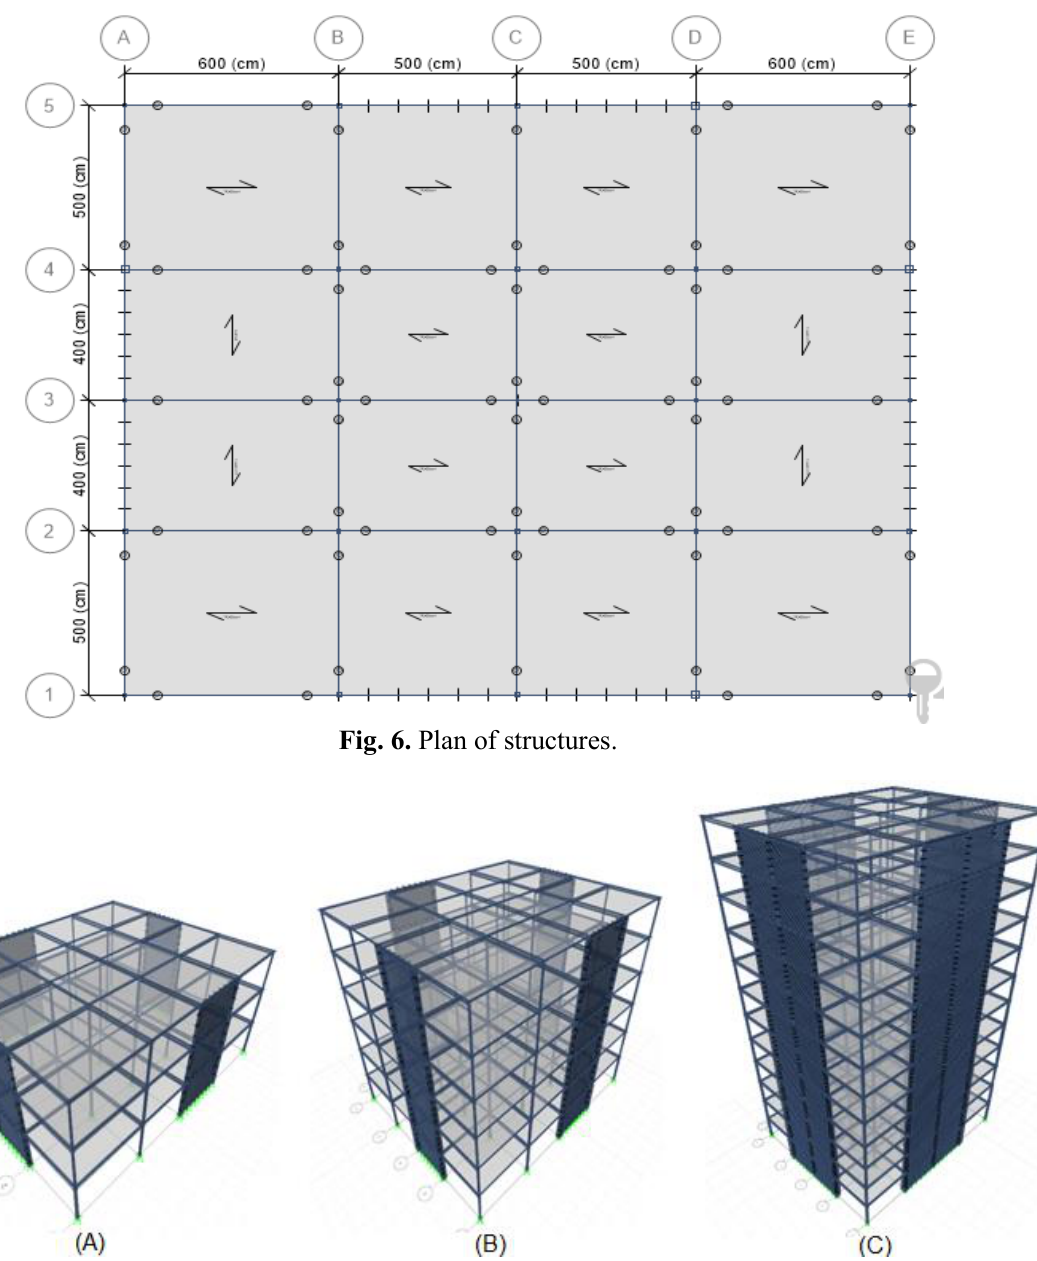
Fig. 7. 3D model of 3 (A), 6 (B) and 12-story (D) structures with Steel shear